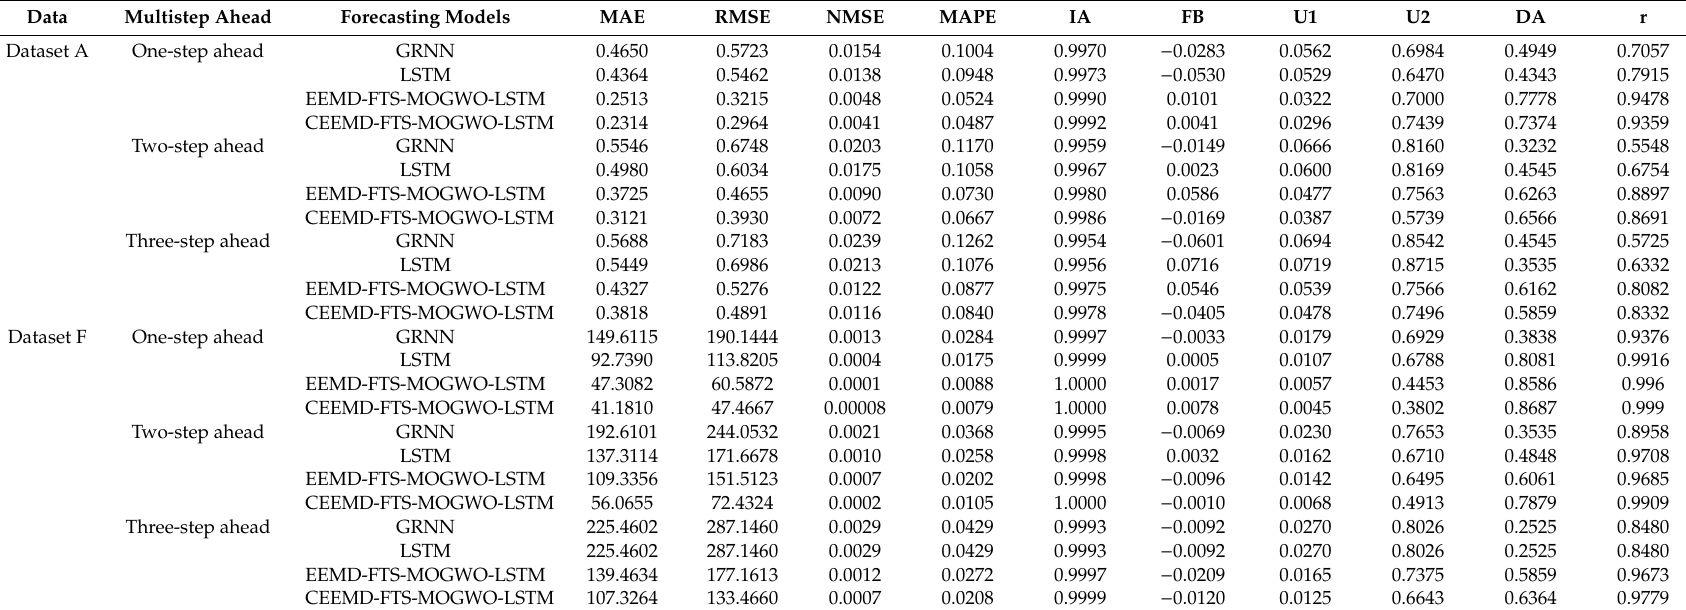
Table 13. Results for the multistep-ahead